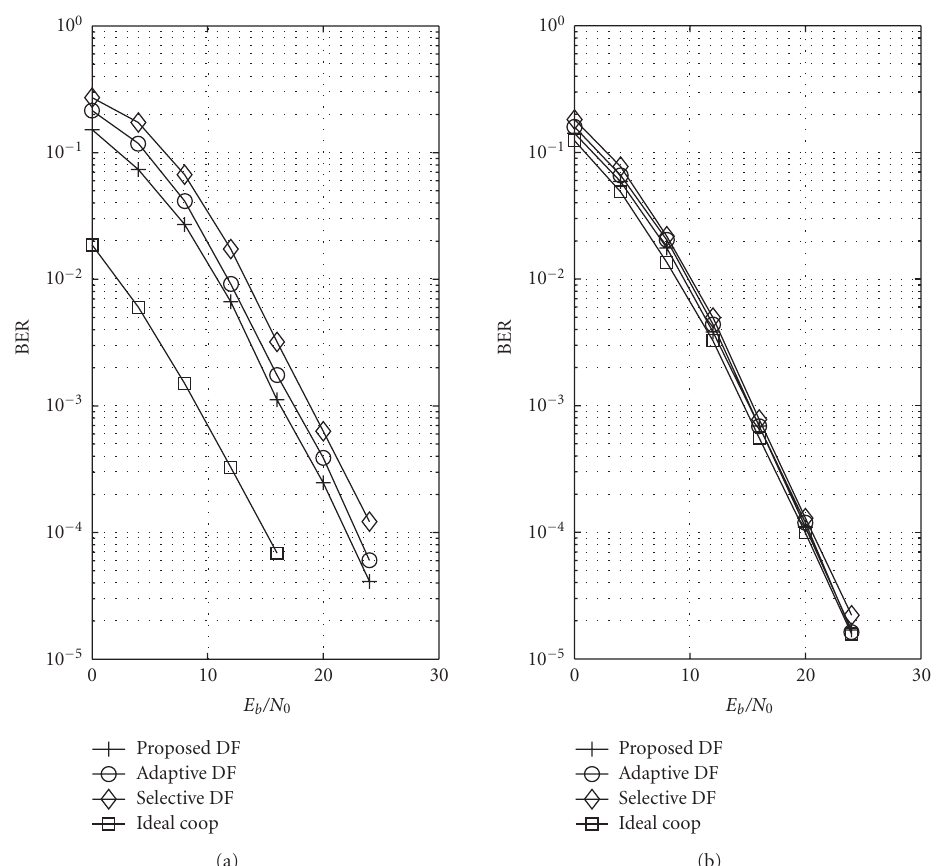
Figure 2: Performance curves when ( d SR = 0 . 7, d RD = 0 . 3) and ( d SR = 0 . 3, d RD = 0 .